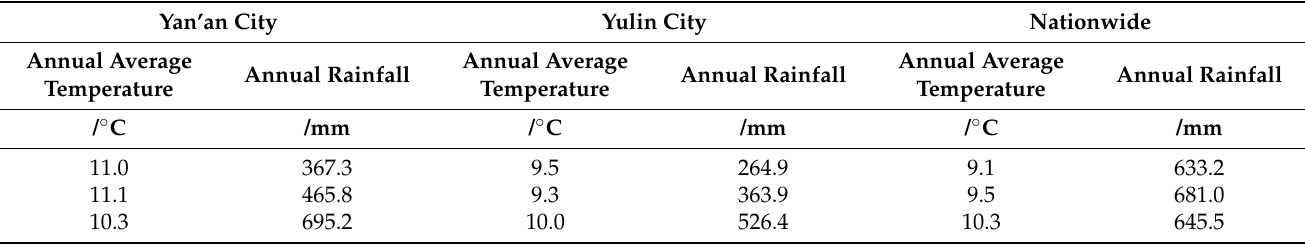
Table 1. Annual average temperature and annual precipitation in Yan’an, Yulin, and nationwide. Yan’an City